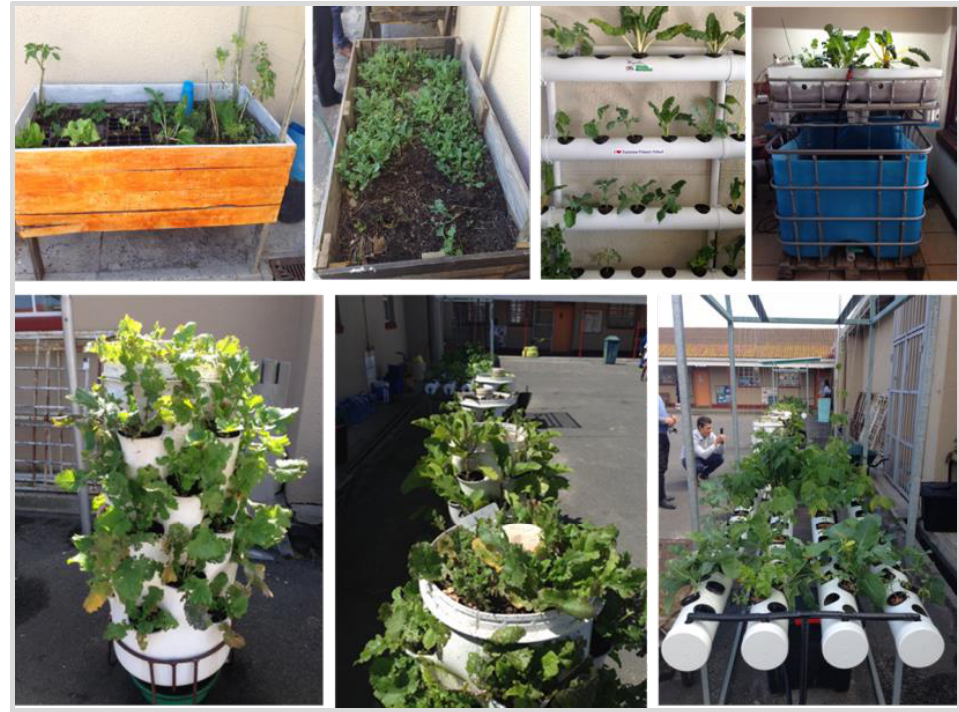
Figure 1. Photographs of vegetable gardening at the participating school.